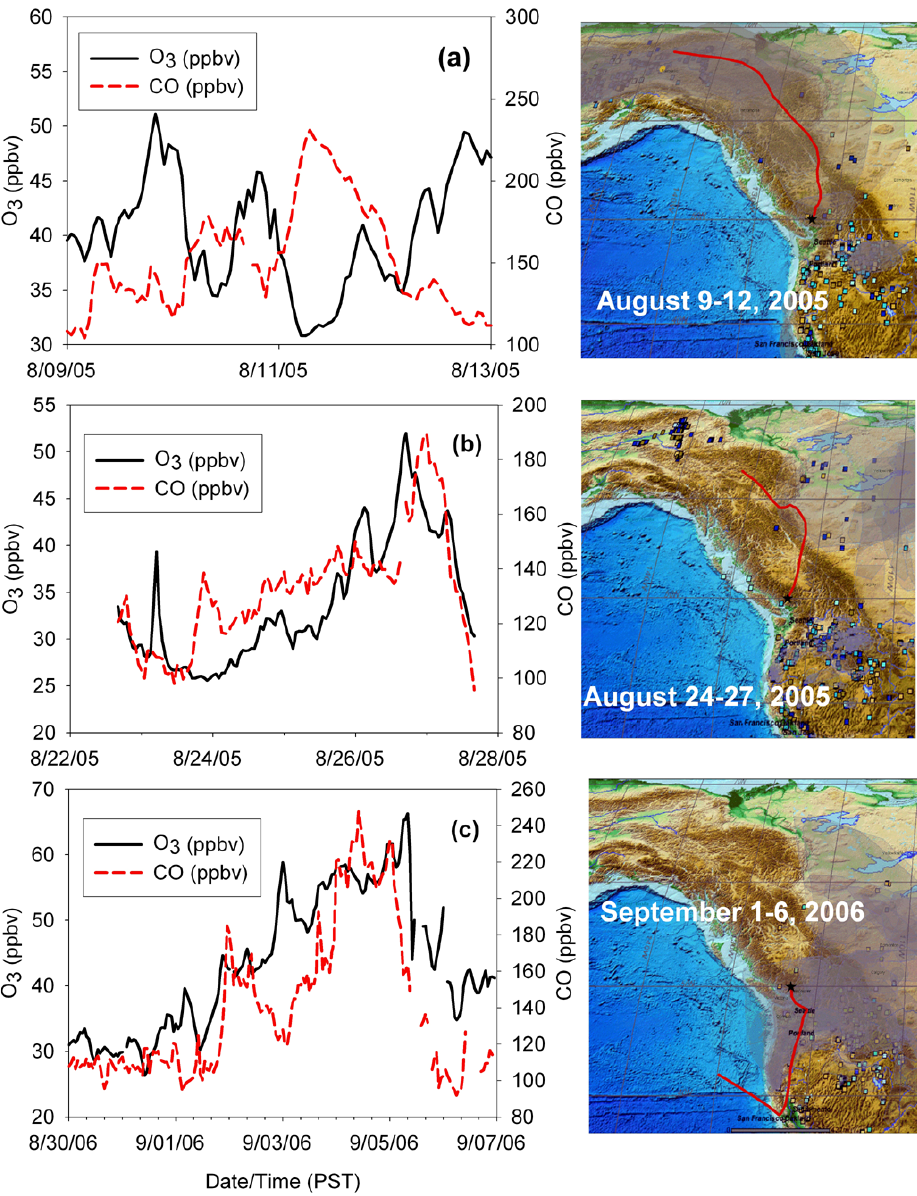
Fig. 11. Time series of O 3 and CO mixing ratios and analyzed smoke from the NOAA emission viewer for (a) 9–13 August 2005; (b) 22–27 August 2005; (c) 31 August–6 September 2006. The panels on the right show analyzed smoke from the NOAA emission viewer with the 750hPa back trajectory from Whistler